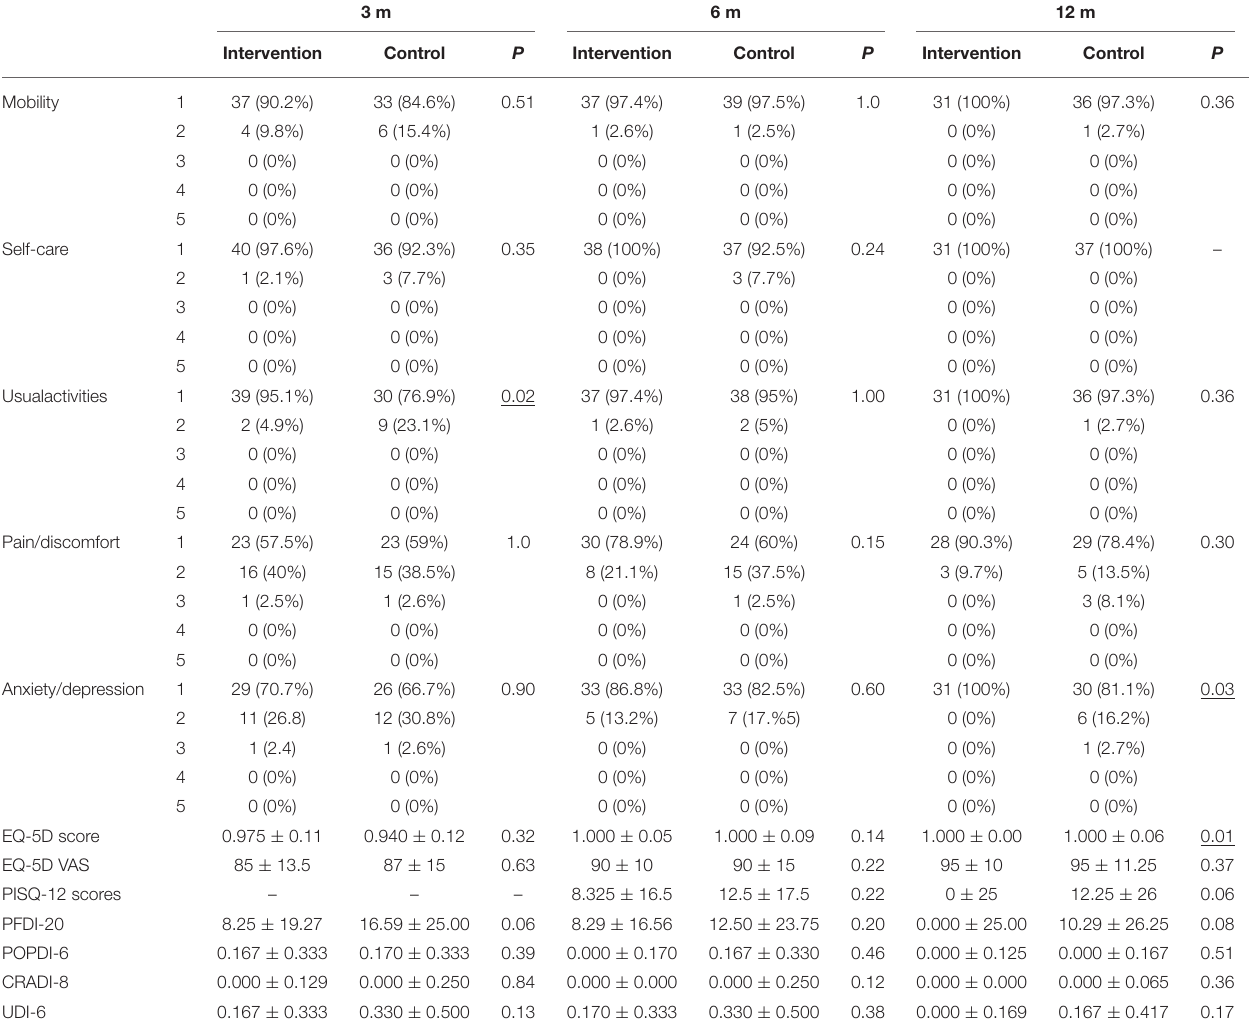
TABLE 5 | The QoL-questionnaire scores between the two groups at 3 rd mo., 6 th mo., and 12 th mo. after